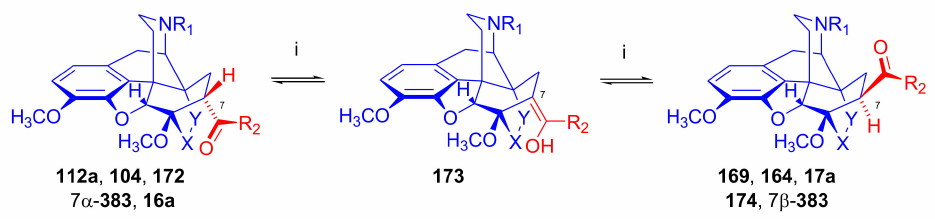
Figure 44. Epimerization and Schmidt reaction of N 17 -cyclopropymethyl-dihydronorthevinone. Reagents and conditions : (i and ii): 37% HClO 4 , NaN 3 , 70 ◦ C, 16 h.